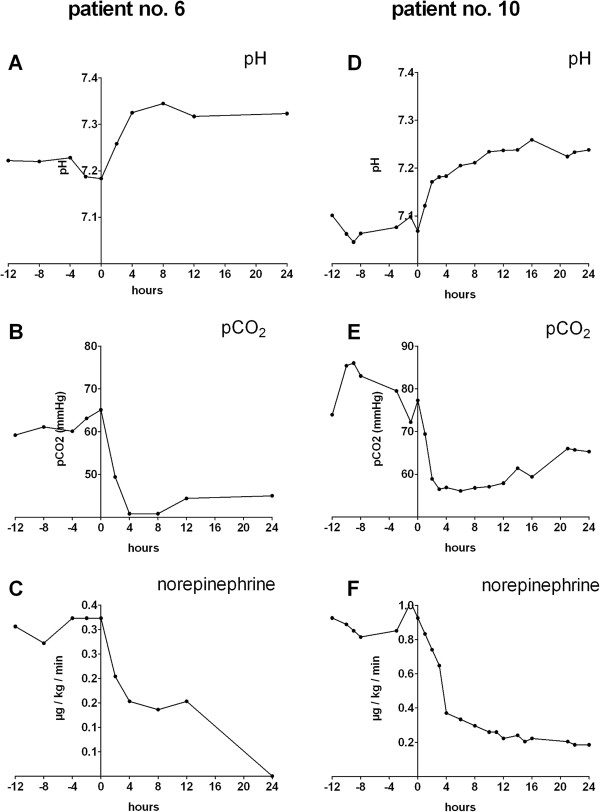
Exemplary time courses for clinical effects of low-flow CO2 removal in two patients. Patient 10 had acute pneumonia (A, B, C); patient 6 had cardiomyopathy and acute pneumonia (D, E, F) for pH, pCO2, and norepinephrine dose, respectively.